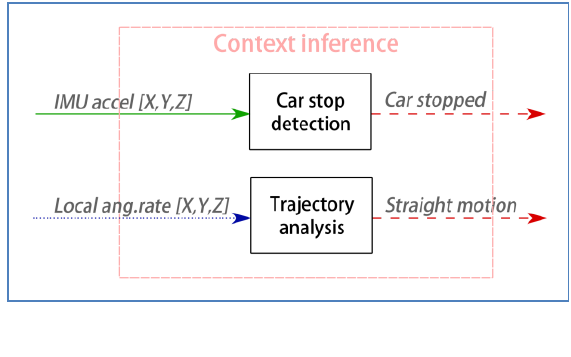
Figure 8. Context inference module. Current